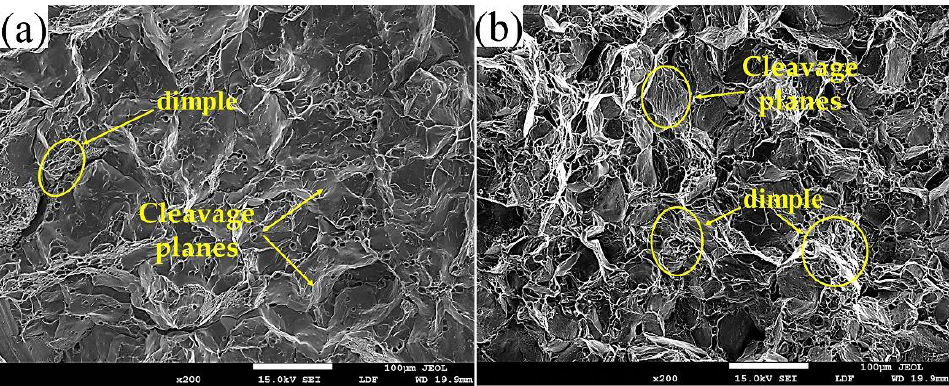
Figure 8. Tensile fracture morphology of the alloy under different conditions: ( a ) Without Sc; ( b ) With Sc.